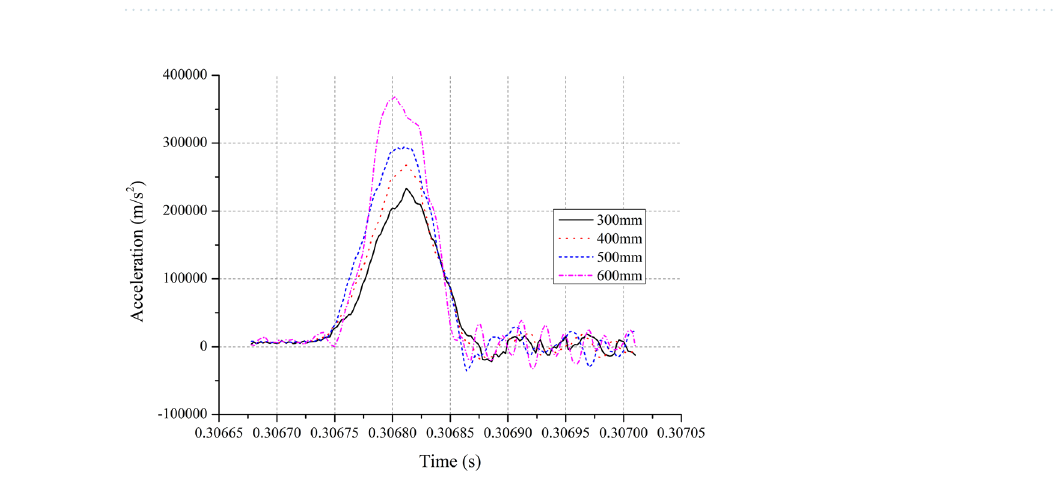
Figure 4. Acceleration–time curves of